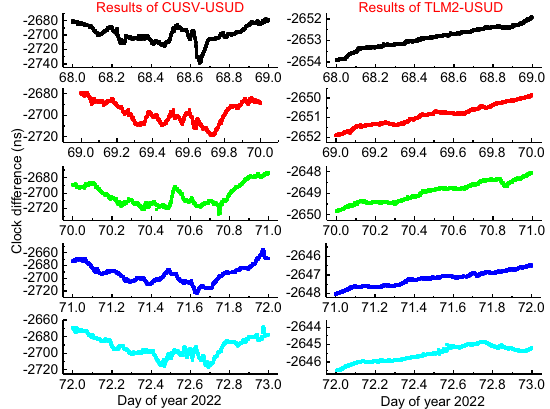
Fig. 3 Clock differences of CUSV-USUD and TLM2-USUD from GPS Fig. 4 Clock differences of CUSV-USUD and TLM2-USUD from BDS-3 Fig. 5 Clock differences of CUSV-USUD and TLM2-USUD from BDS-3/ GPS PPP in Scheme